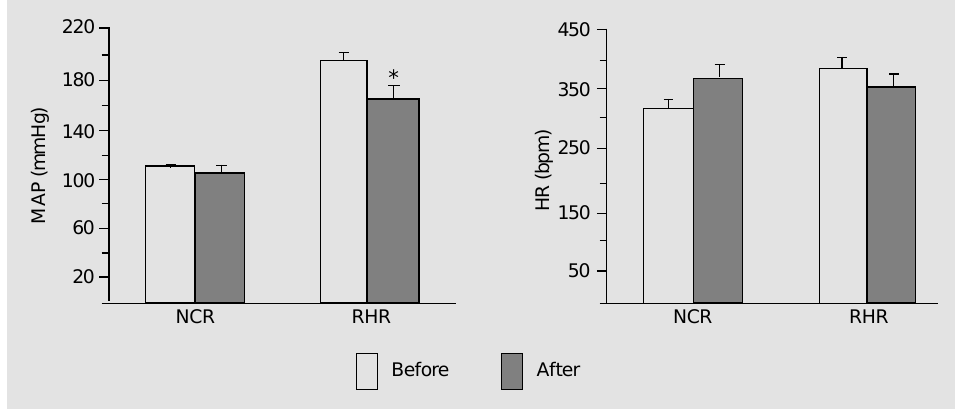
Figure 1 - Mean arterial pressure (MAP) and heart rate (HR) of conscious normotensive control rats (NCR) or chronic 1K1C renal hypertensive rats (RHR), before and after acute administration of losartan (10 mg/kg, iv ). *P<0.05 compared to before losartan (Student t -test). M A